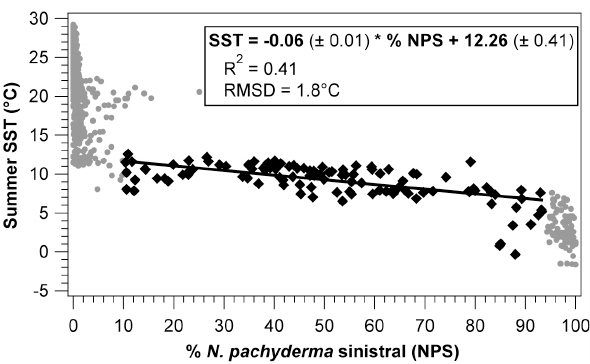
Fig. 1. Linear relationship defined between summer SST and the percentage of the polar planktic species Neogloboquadrina pachyderma sinistral (NPS) in the North Atlantic. We used the MARGO database from the North Atlantic (Kucera et al., 2005). The relationship (thick black line) is defined for summer SST below 15 ◦ C and percentages of N. pachyderma sinistral between 10% and 94% (black diamonds). The grey circles represent the other sites of the database characterized by SST values above 15 ◦ C or by percentages of N. pachyderma sinistral above 94% or below 10%. The root mean square deviation (RMSD) of the relationship is ± 1.8 ◦ C (1 σ ).